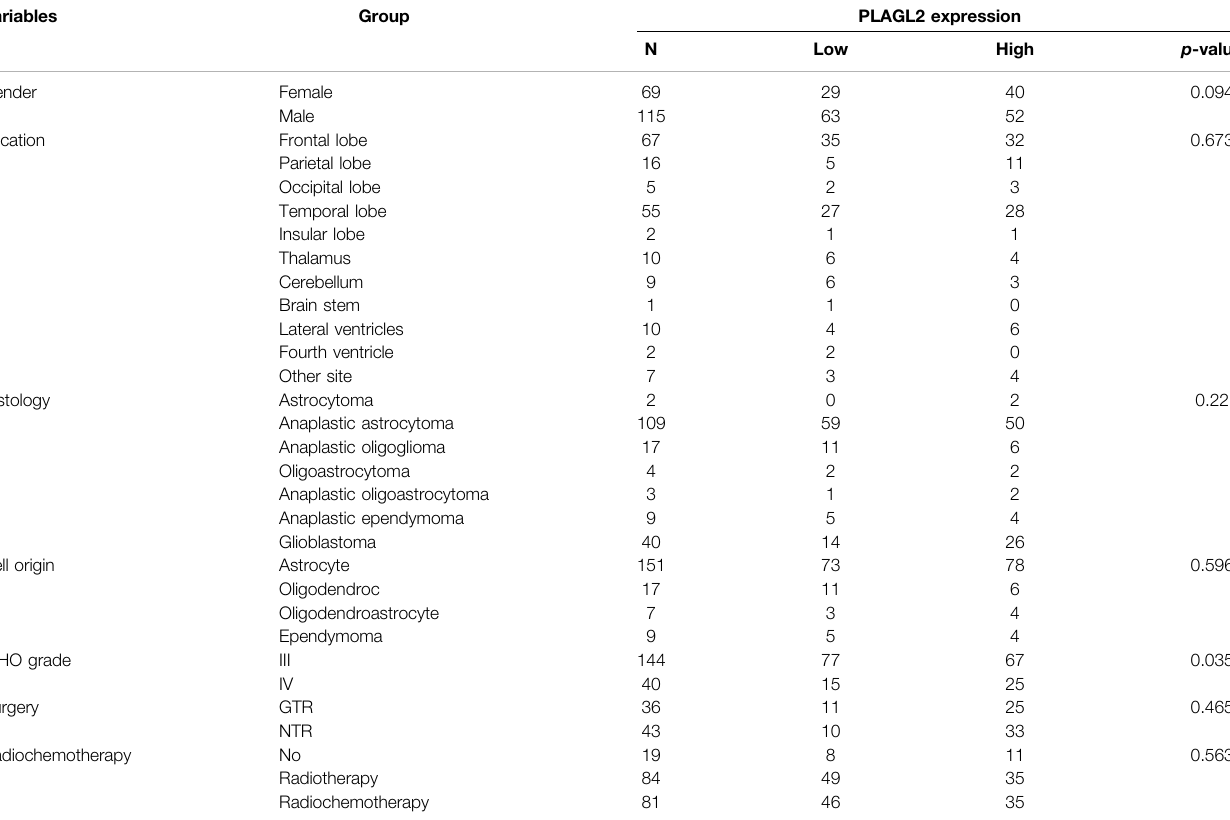
TABLE 1 | Association of PLAGL2 expression in human glioma tissues with different clinicopathological features.